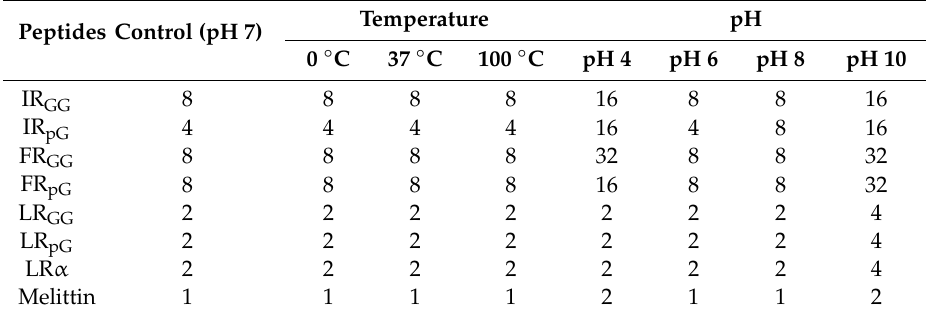
Table 4. The MICs ( µ M) of the designed peptides against E. coli ATCC25922 after temperature and pH treatment.